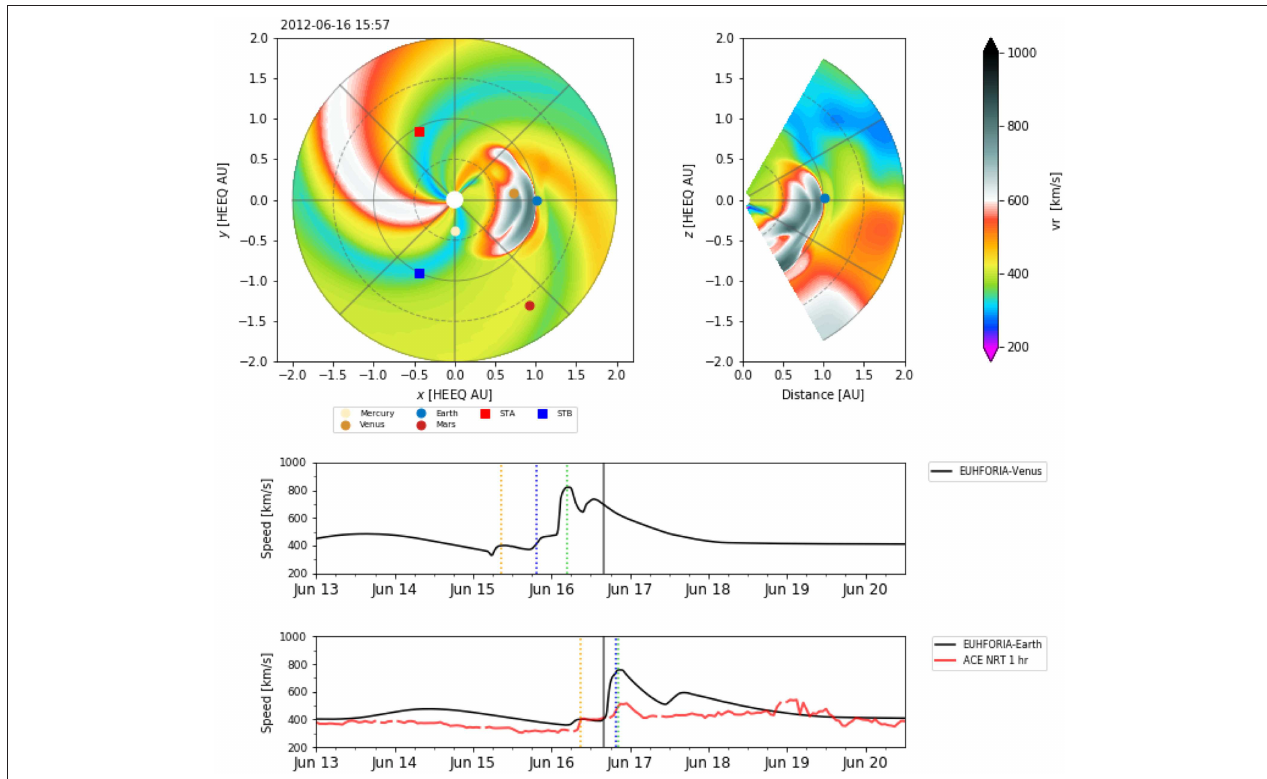
FIGURE 3 | Snapshot of the solar wind speed simulated with EUHFORIA, showing the arrival at Earth of CME3 around June 16, 2012 at 16:00 UT. The heliographic equatorial plane (Left) and the meridional plane containing Earth (Right) are shown, together with the time series at Venus and Earth (Bottom) . The arrival times of the CME-driven shocks taken from in-situ data for both locations (analyzed in section 3.3) are indicated in the time series with vertical dashed lines (CME1, orange; CME2, blue; CME3, green).